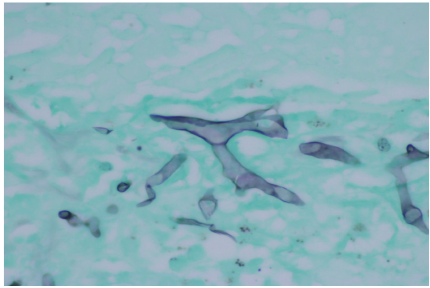
Figure 3: This image shows several hyphae, exhibiting the typical 45 degree branching and septate forms characteristic of Aspergillus . Gomori Methenamine Silver stain, 60x